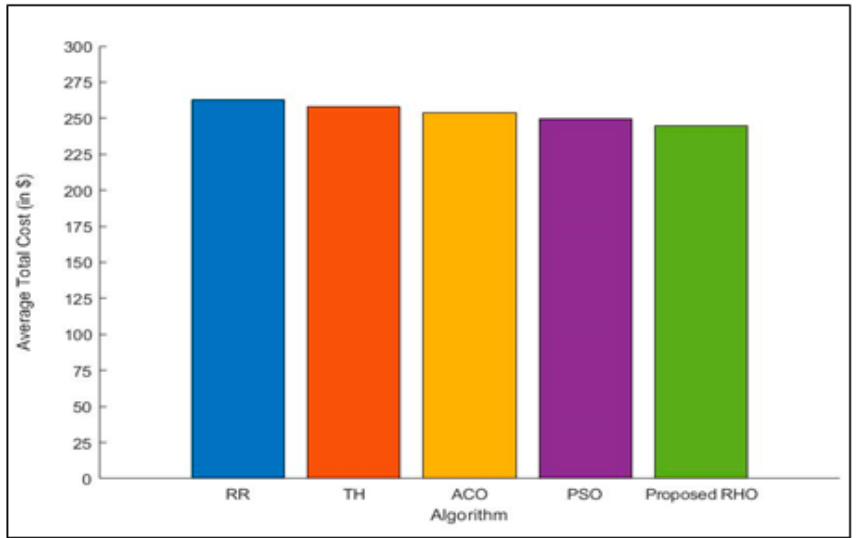
Figure 8. Average Total Cost for different algorithms.